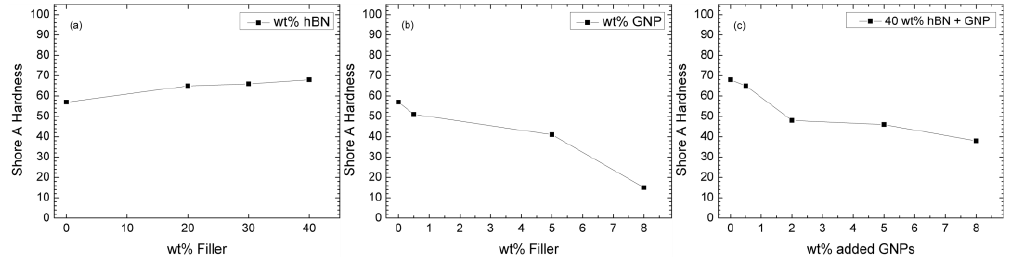
Figure 8. Results of Shore A hardness measurements for PDMS-based composites containing: ( a ) hBN; ( b ) GNPs; ( c ) 40 wt% hBN and different amounts of GNPs.